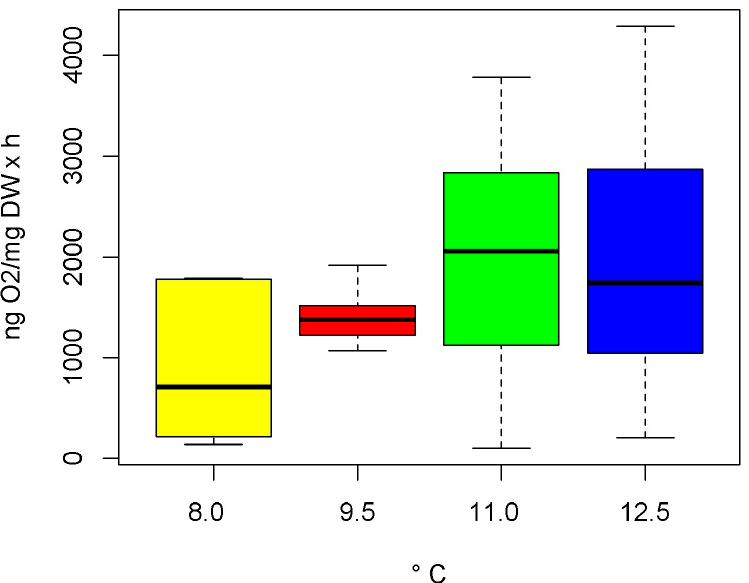
Figure 5. Boxplot of oxygen consumption rates (OCR in ng O 2 /mg DW × h) of adult females of Moraria sp. at 8.0 ◦ C (average annual temperature of the collection site), 9.5, 11.0, and 12.5 ◦ C. Boxplots are delimited by the first and third quartiles and divided internally by the median. Whiskers indicate variability outside the upper and lower